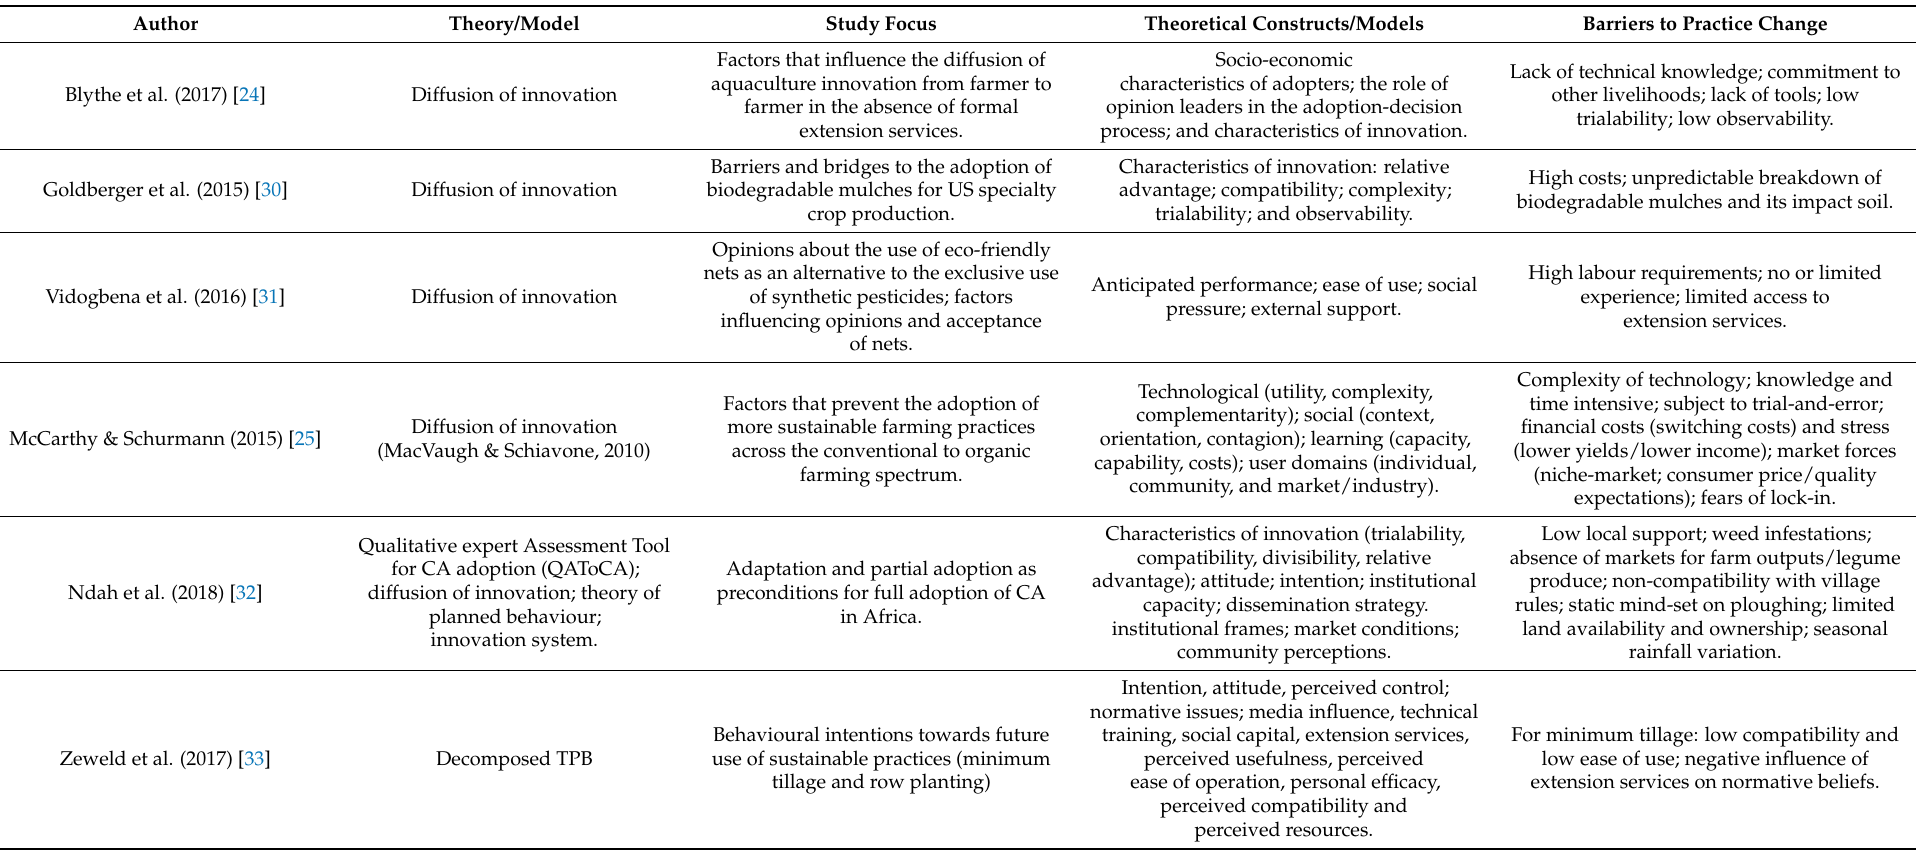
Table 2. Study focus and summary of barriers to practice